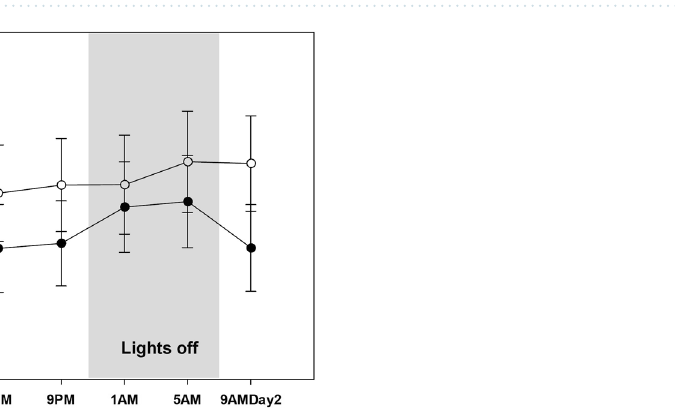
Figure 3. The top images ( a – c ) plots, across 24 h, sub-foveal and sub-parafoveal choriocapillaris flow deficit density and sub-parafoveal choriocapillaris flow deficit size in myopes and non-myopes. Significant time by refractive group interactions (P < 0.05) were found in the three indices with myopes and non-myopes demonstrating different pattern of variation. For all time points, error bars indicates one standard error of the mean. The bottom images ( d – f ) shows polar diagrams for sub-foveal and sub-parafoveal choriocapillaris flow deficit density and sub-parafoveal choriocapillaris flow deficit size depicting diurnal amplitude of change (distances from center) plotted against acrophase time (around the perimeter, 24-h clock) in myopes and non- myopes.